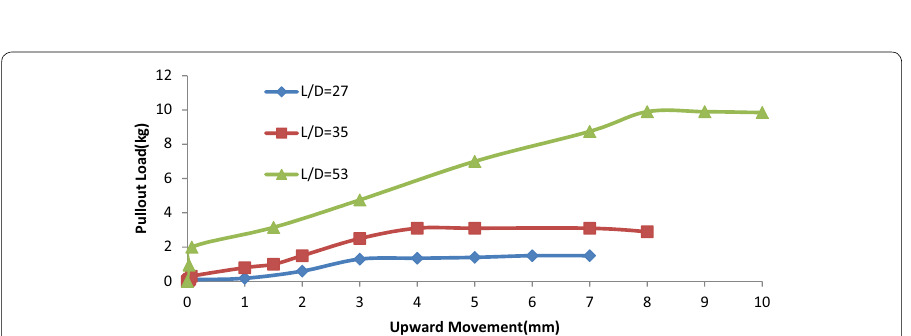
Fig. 18 Pullout load-upward movement curves for helical pile with double helix (dh